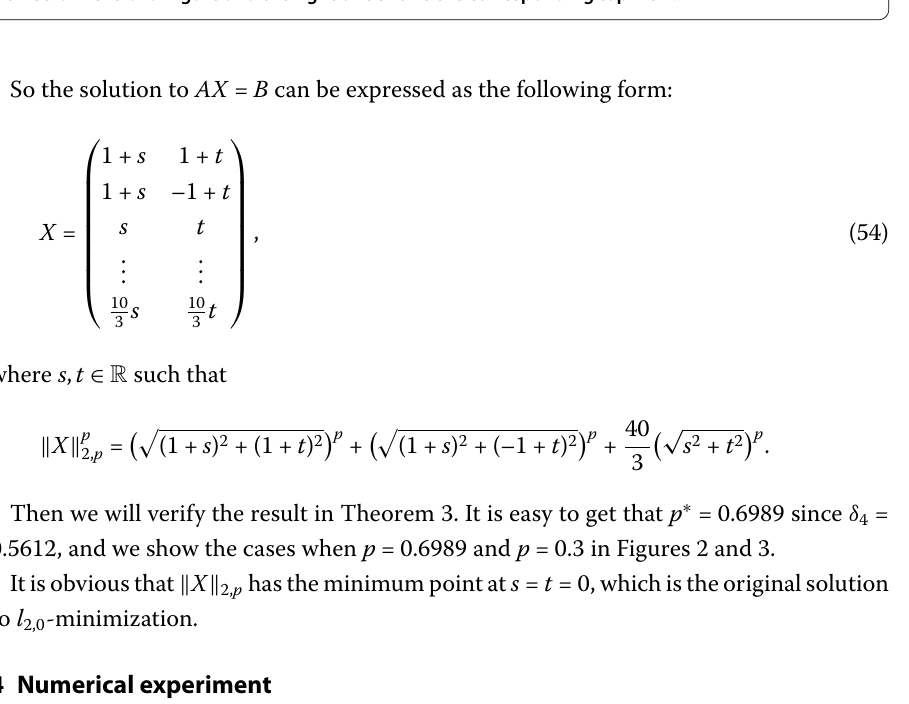
Figure 3 The norm of the solution in Example 2 when p = 0.3, the left one shows the three-dimensional figure and the right one shows the corresponding top